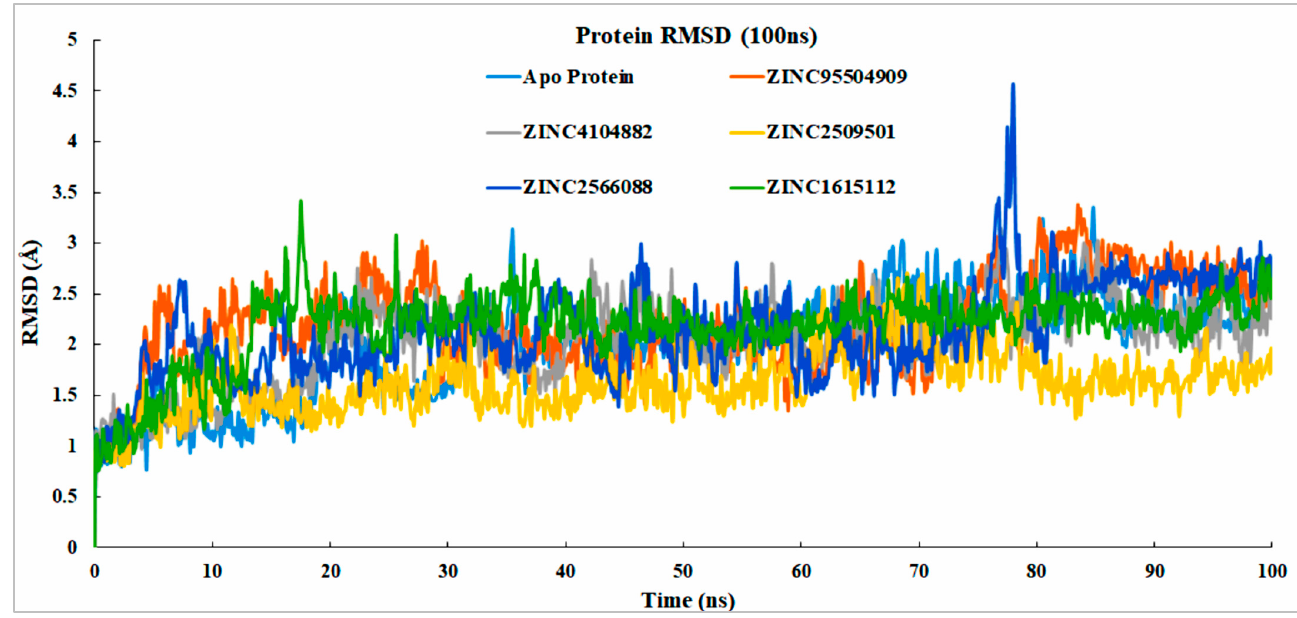
Figure 7. RMSD values of the protein were determined from the C α of the protein–ligand docked complex. Apo-Protein (light blue), ZINC95504909 (orange), ZINC4104882 (gray), ZINC2509501 (gold), ZINC2566088 (blue), and ZINC1615112 (green).